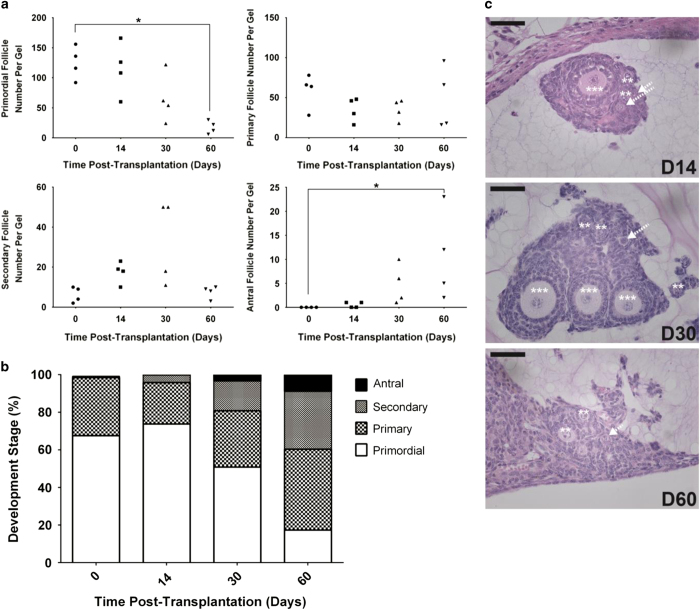
Follicle development and progression through the developmental stages. (a) The number of follicles in each graft at different stages after transplantation. There was a decreasing trend of the primordial follicle number in grafts over 60 days as a result of entering the growing pool every estrous cycle, ovulate and become corpus lutea. The distribution in the follicle numbers before transplantation resulted due to the loss of follicles during encapsulation process (ngel=4 from four mice, for each time point). Statistical significance was determined by the Kruskal–Wallis test followed by Dunn’s post-test (P<0.05). (b) Graft composition and percentage of the follicles at each developmental stage. After 14 days in vivo the majority of the implanted follicles were at primordial stage, similar to the graft composition at the implantation. After 30 days, 15% of the implanted follicles reached a preantral stage and 5% were antral. The percentage of primordial follicles decreased and the percentage of growing follicles increased over 60 days in vivo. 60% of immature follicular pool, including both primordial and primary follicles, was still presented in the grafts. (c) Primordial and primary follicles present at day 14, 30 and 60 after implantation (Primordial follicles (dashed arrow), Primary follicle (**), Secondary follicle (***)). Scale Bar=50 μm.